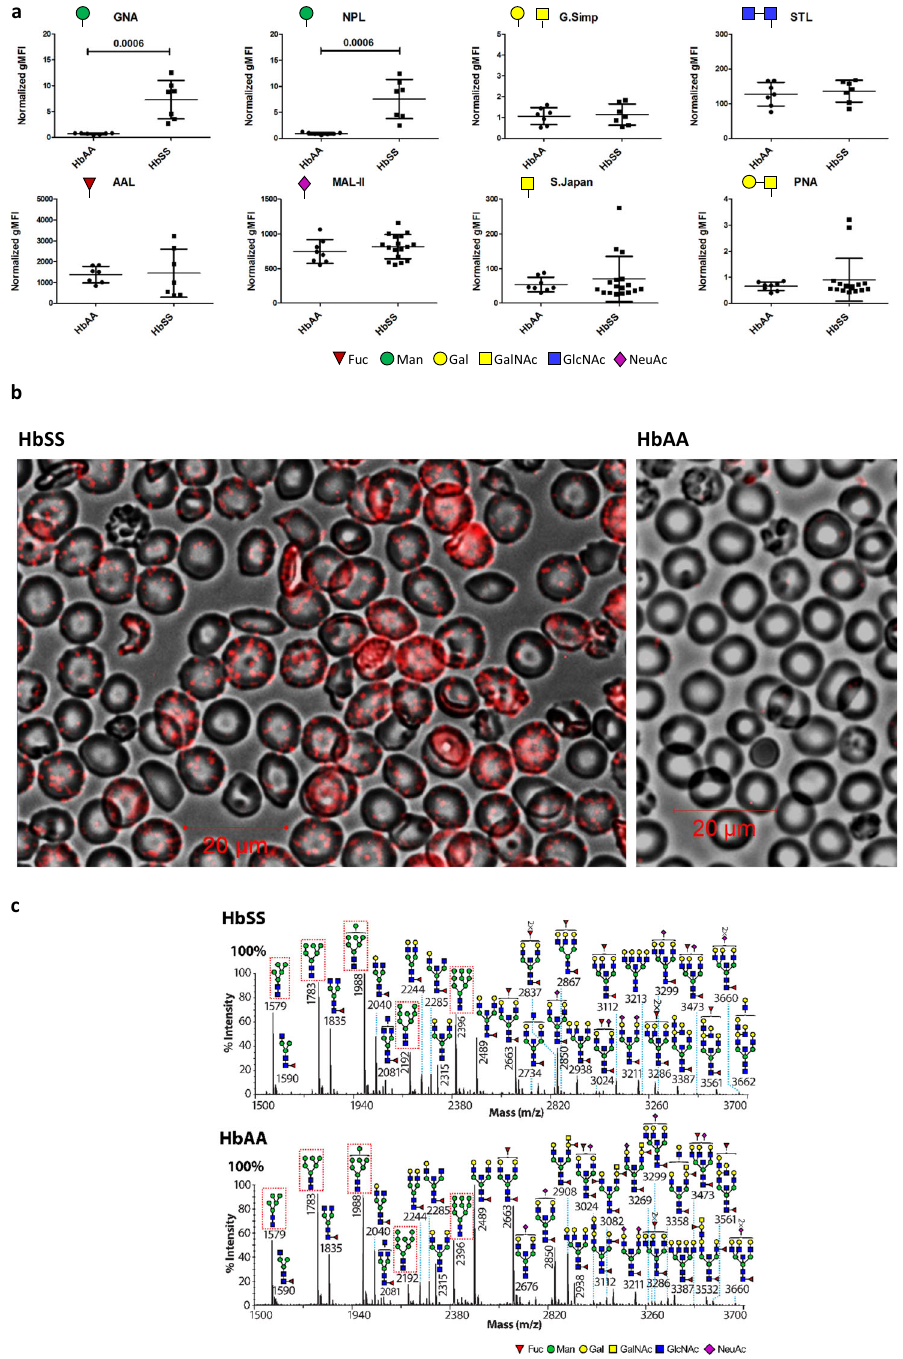
Fig. 1 HbSS RBCs are characterized by microdomain expression of surface mannoses. Whole blood fl ow cytometry analysis of HbAA (normal hemoglobin) and HbSS (homozygous sickle cell hemoglobin) RBCs using fl uorescently labeled plant lectins, detailed in “ Methods ” section. Vertical axes show normalized geometric mean fl uorescence (gMFI). Symbols of terminal carbohydrates detected by plant lectins are indicated. Data shown as median + / − IQR, n = 7 per group for signi fi cant differences, 2 tailed Mann-Whitney p values shown, distinct samples measured once each, 3 separate experiments. Annotation uses conventional symbols for carbohydrates in accordance with http://www.functionalglycomics.org guidelines: purple diamond, sialic acids; yellow circle, galactose; blue square, N-acetyl glucosamine; green circle, mannose; red triangle, fucose. a Galanthus nivalis Agglutinin (GNA) lectin staining (red) of HbSS and HbAA RBCs, immuno fl uorescence, merged with the bright fi eld. b MALDI-ToF mass spectra ( m / z versus relative intensity) for glycomic analysis of N-glycans from membrane ghosts from individual HbSS and HbAA donors. Red boxes indicate high mannose structures. Annotation uses conventional symbols for carbohydrates in accordance with http://www.functionalglycomics.org guidelines: purple diamond, sialic acids; yellow circle, galactose; blue square, N-acetyl glucosamine; green circle, mannose; red triangle, fucose. Only major structures are annotated for clarity. Full spectra from both HbSS and HbAA donors are shown in Supplementary Fig.